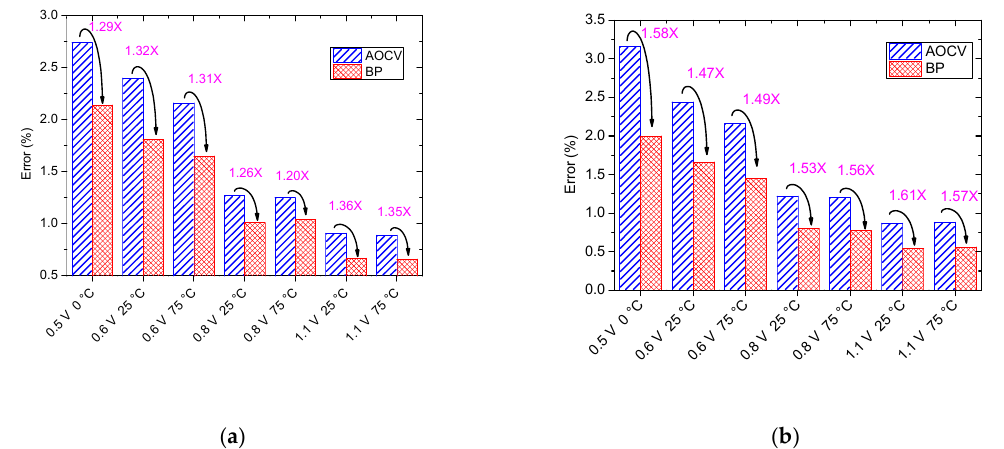
Figure 4. Path variation delay training error at td - x σ at a single corner. ( a ) train error; ( b ) test error.